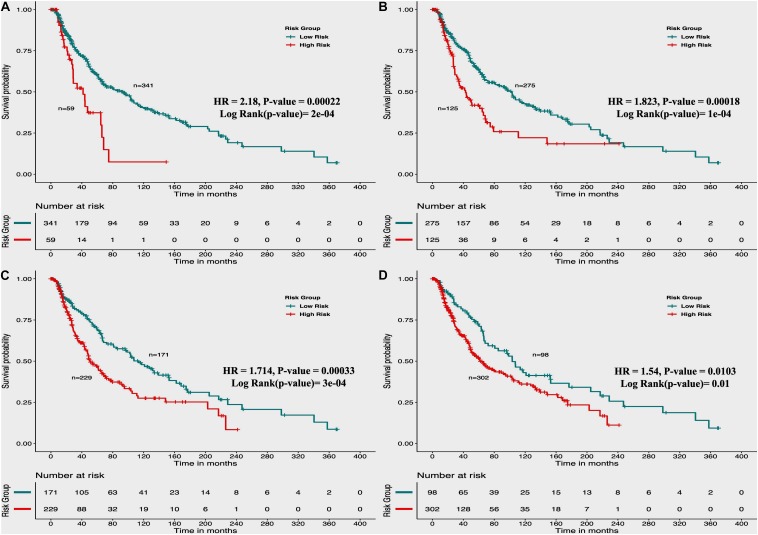
Kaplan Meier (KM) survival curves for the risk estimation of melanoma patient cohort based on the risk score with significant p-value (A) Melanoma samples stratified on the basis of cut-off (≥2 Risk Score), (B) Stratified samples by taking cut-off (≥1 Risk Score), (C) Stratified samples by taking cut-off (≥0 Risk Score), (D) Stratified samples by taking cut-off (≥–1 Risk Score).